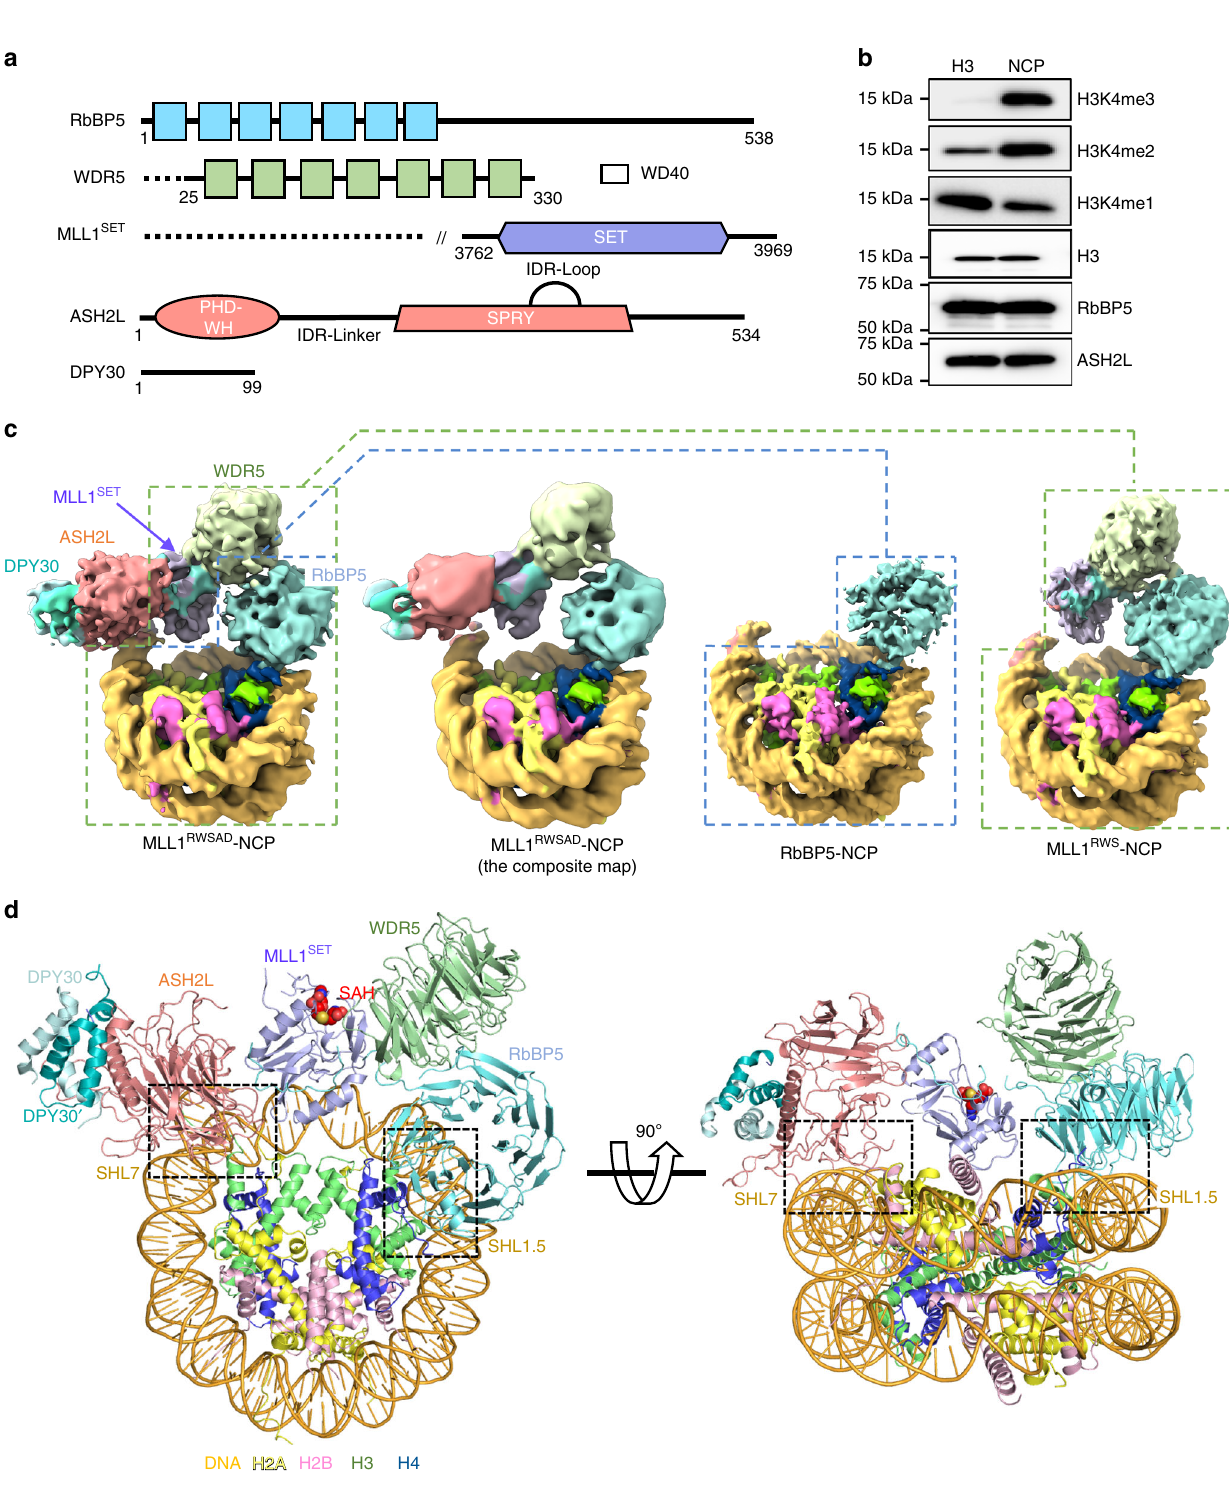
Fig. 1 Cryo-EM structure of the MLL1 RWSAD -NCP complex. a Schematic domain architectures for the core components of the human MLL1 complex used in the cryo-EM study. b Immunoblot to detect H3K4 methylation in the in vitro histone methyltransferase assay. Antibodies indicated on right. The substrates were free recombinant histone H3 (left) and the NCP (right), respectively. Immunoblots for unmodi fi ed H3 as well as RbBP5 and ASH2L included as controls. c Cryo-EM 3D reconstruction of the MLL1 RWSAD -NCP complex. The composite map of MLL1 RWSAD -NCP was locally fi ltered to the estimated resolution. The subcomplexes, i.e., RbBP5-NCP and MLL1 RWS -NCP, shown in dashed boxes. d Top (left) and front (right) views of the MLL1 RWSAD -NCP structure. The S -adenosyl- L -homocysteine (SAH) was represented as a sphere (red) and the MLL1 core components shown in cartoon representation (RbBP5: cyan, WDR5: green, MLL1 SET : slate, ASH2L: pink, and DPY30 dimer: cerulean and teal). Widom 601 DNA and four histones were colored as indicated on the bottom. Two black dashed squares highlighted the nucleosome contact points near SHL1.5 and SHL7 by MLL1 RWSAD . Illustrations of the protein structure and cryo-EM maps used in all fi gures were generated with PyMOL (Delano Scienti fi c, LLC) and Chimera 67 /ChimeraX 70